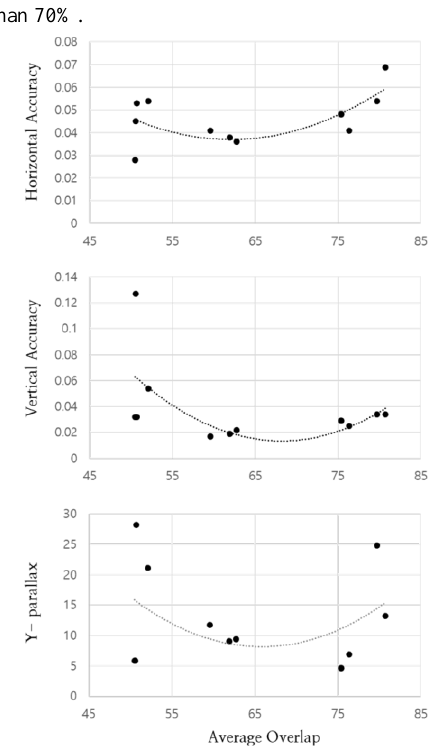
Figure 12. Relationship between average Overlap